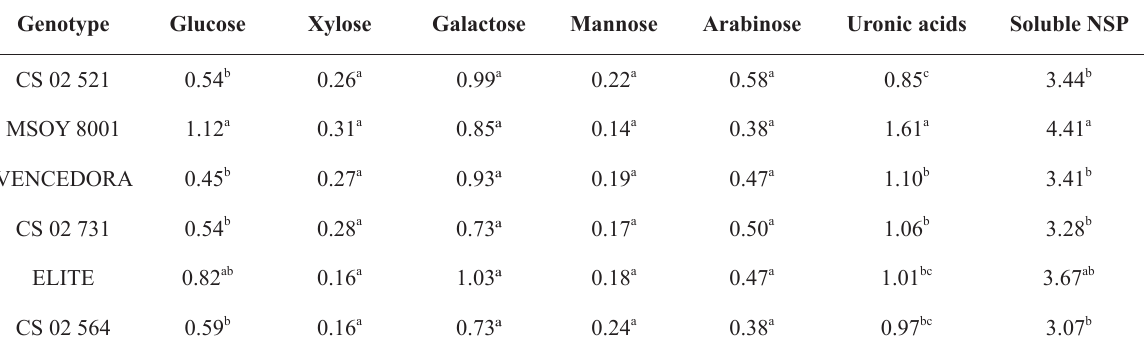
Mean concentrations of soluble NSP and its constituent (monosaccharides and uronic acids) in six soybean genotypes, expressed in dry matter